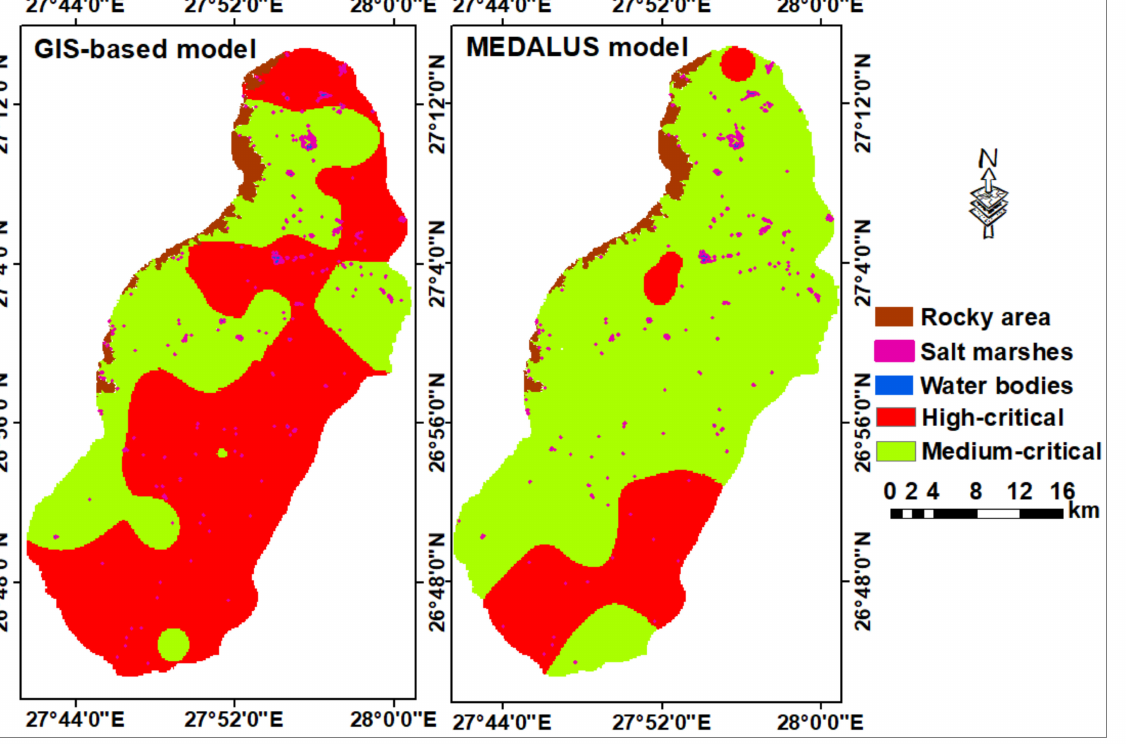
Figure 7. Maps of sensitive areas to desertification in the studied